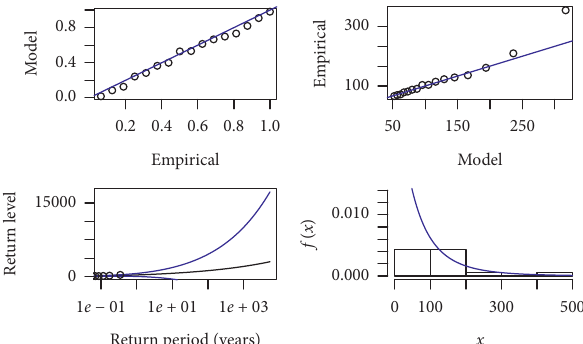
Figure 6: Diagnostic plots of damage areas. (a) Probability plot. (b) Quantile plot. (c) Return level plot. (d) Density plot.